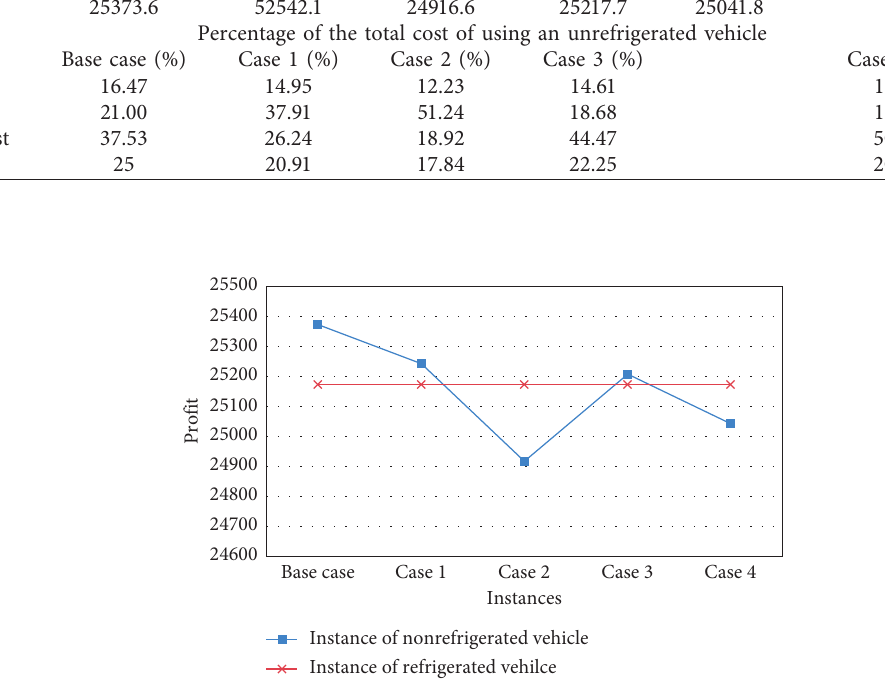
Figure 5: Comparison of nonrefrigerated and refrigerated vehicle